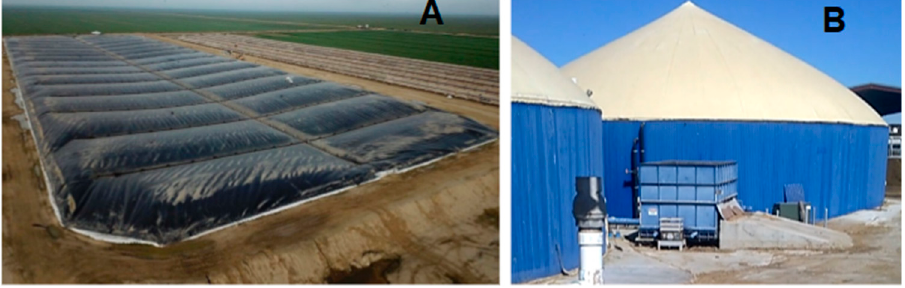
Figure 2. Common digester types on dairies: ( A ) covered lagoon [4], and ( B ) above-ground CSTR